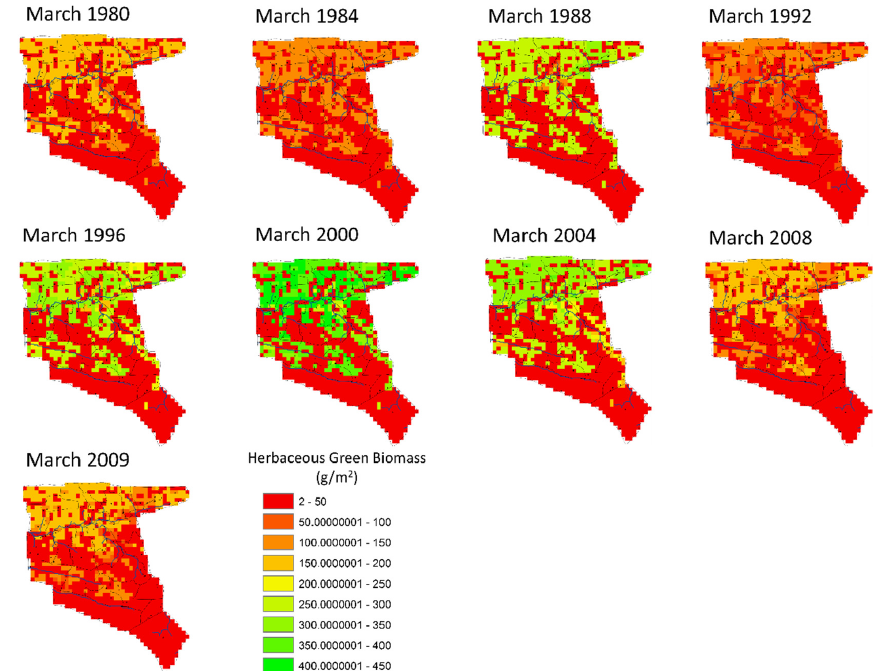
Figure 9. The spatial distribution of herbaceous green biomass for selected years (March every 4th year of the historic scenario). Appl. Sci. 2020 , 10 , x FOR PEER REVIEW